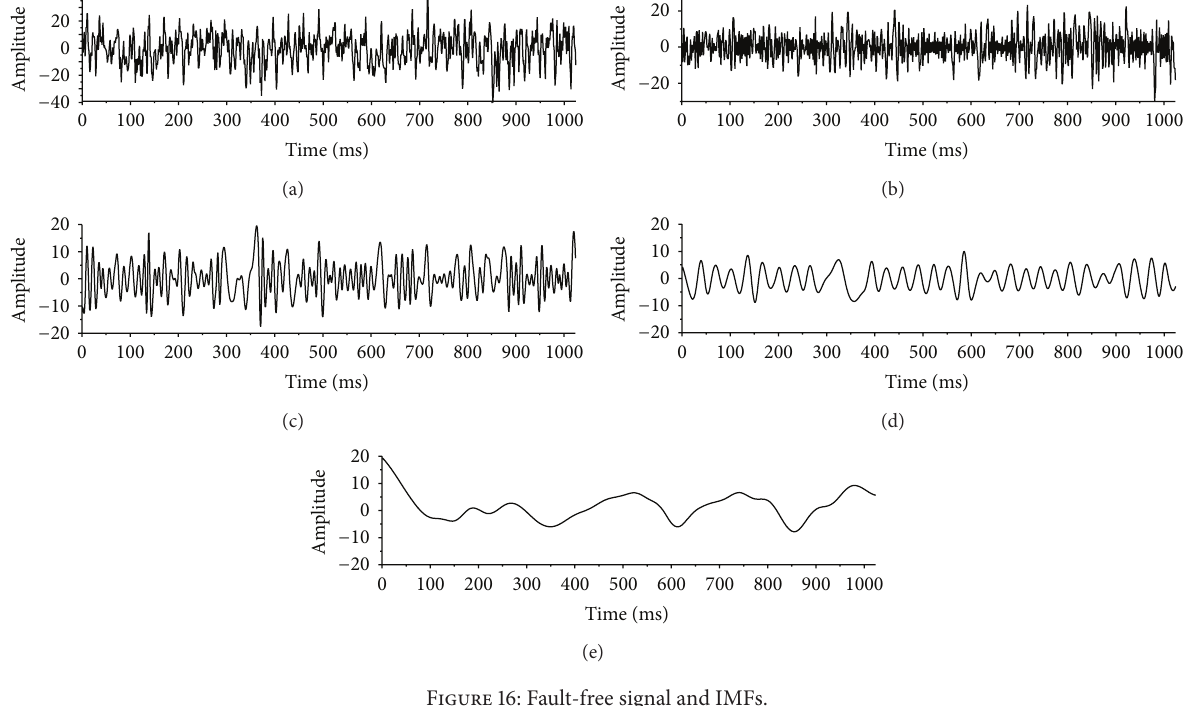
Figure 16: Fault-free signal and IMFs.